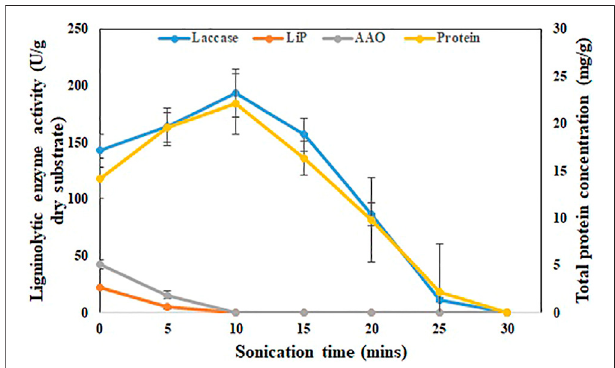
FIGURE 2 | Effect of ultrasonication on recovery of laccase from SBS. Enzyme activity (U/g) and protein concentration (g/L) with respect to time during sonication for 30 min. The experiments were done in triplicate and the error bar represents the standard deviations in each set of